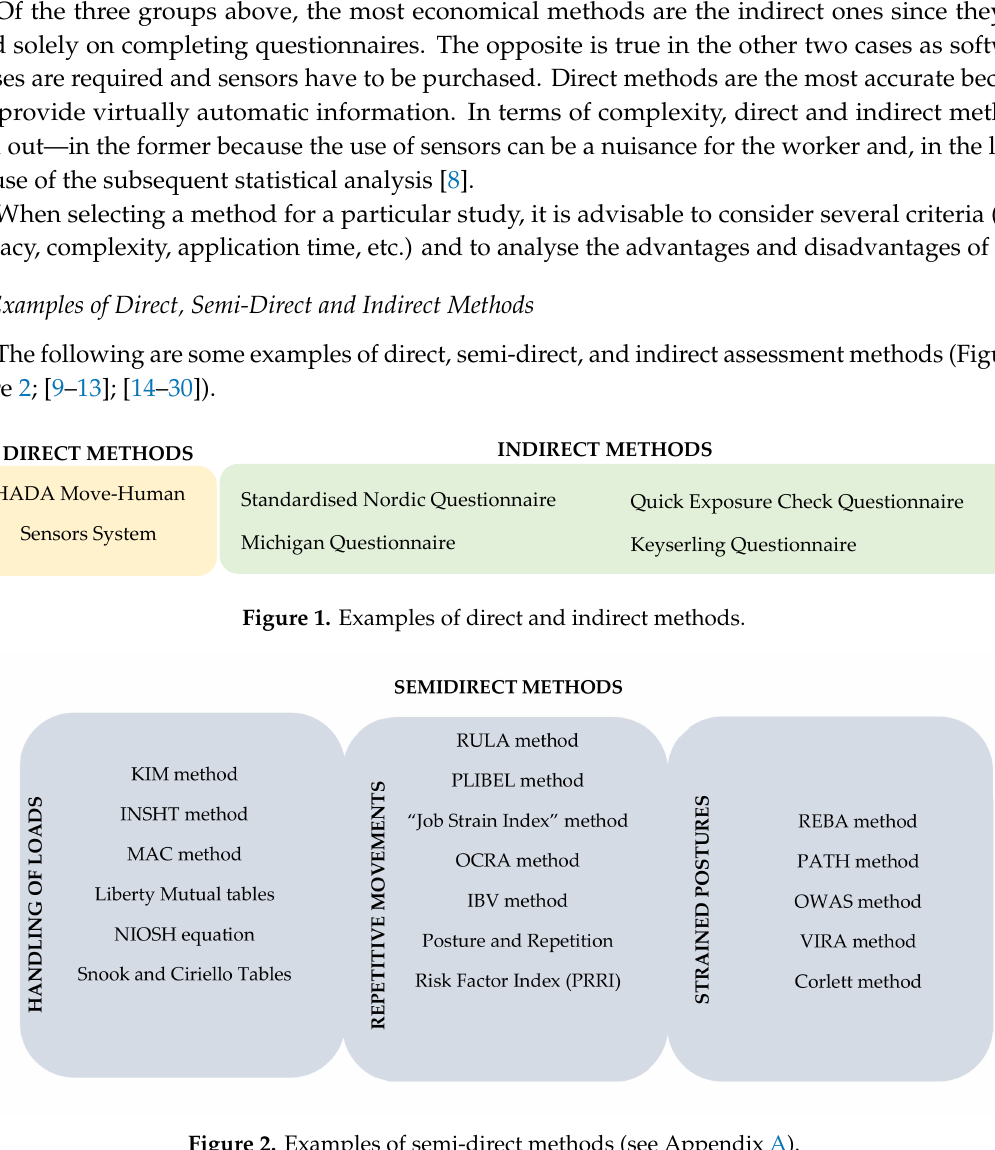
Figure 2. Examples of semi-direct methods (see Appendix